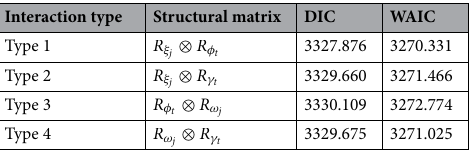
Table 6. The selection information for the four spatio-temporal interaction types on level 2 of the model